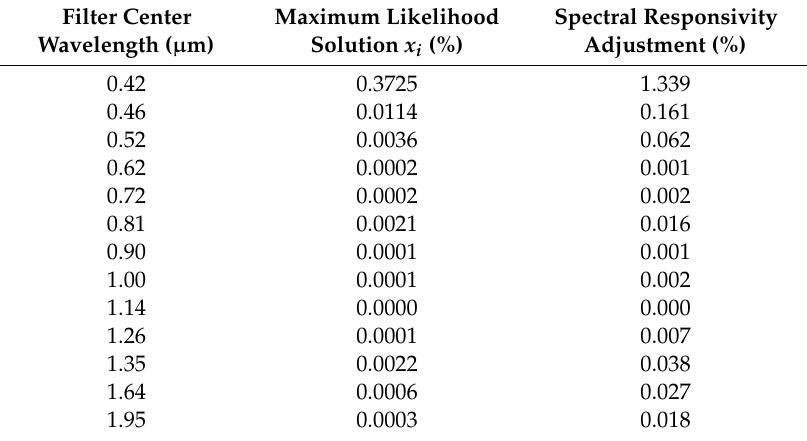
Table 3. Maximum likelihood solution for the adjustments to the spectral responsivity for each of the 13 filter bands to radiometrically scale the SWc of SNPP / FM5 to Aqua / FM3 for global all-sky using the intercomparison dataset for 2014 (adapted from [6]).